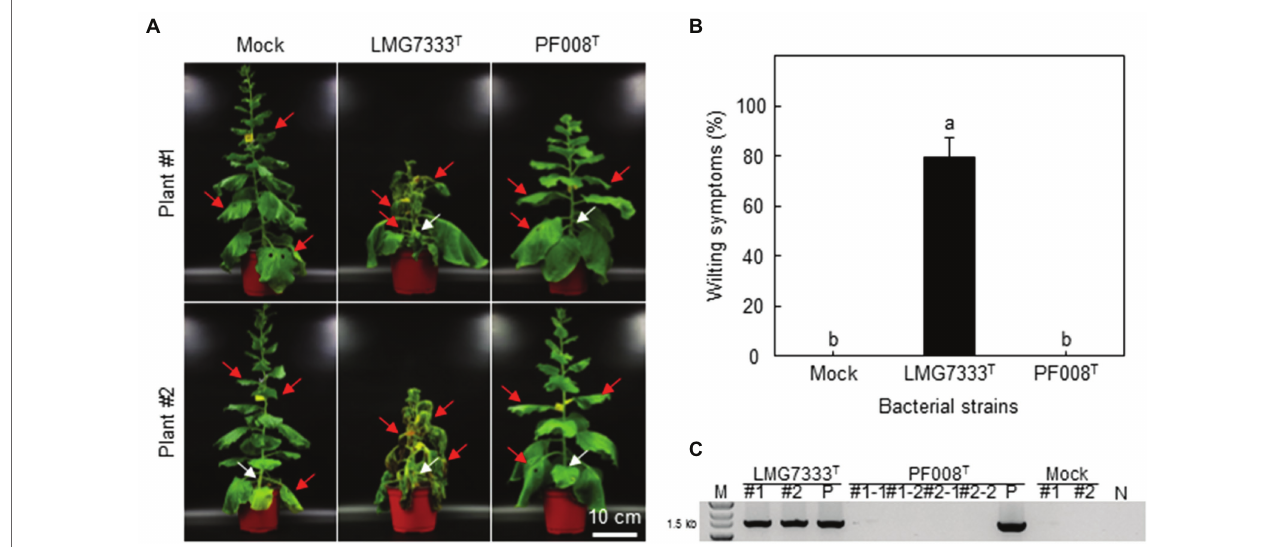
FIGURE 5 | Wilting symptoms caused after stem inoculation with C . michiganensis LMG7333 T , but not after C . capsici PF008 T inoculation in N . benthamiana plants. (A) Wilting symptoms caused in N . benthamiana plants after injection with 20 ul of 10 8 CFU/ml of C . michiganensis LMG7333 T and C . capsici PF008 T . Injection sites in stems are indicated by white arrows. The inoculated plants were photographed at 21 days after inoculation (dai). (B) Quantification of wilting severity in N . benthamiana plants shown in (A) . An average and standard deviation ( n = 4) of wilting severity were obtained from two independent assays. The different letters on top of each bar indicate a statistically significant difference analyzed via Kruskal–Wallis test ( p < 0.05). (C) Identification of inoculated bacteria in two wilted N . benthamiana plants (#1 and #2) via PCR analysis. The leaf disks (1 cm in diameter) were collected at three leaves (indicated by red arrows) from the inoculated